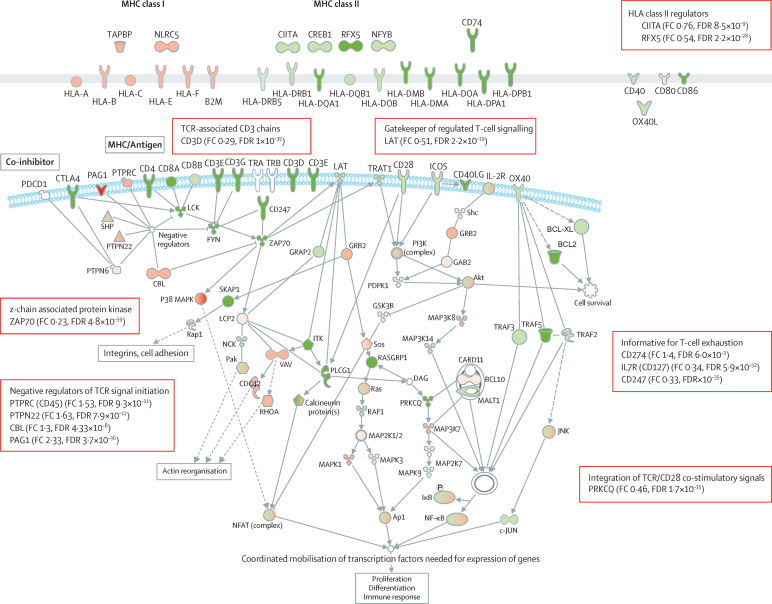
Overview of differentially expressed genes between SRS groups involving HLA and T-cell activationRed shading shows upregulation and green shading shows downregulation of genes (FC>1·5, FDR<0·05) for SRS1 versus SRS2. Solid lines show direct association, dashed lines show indirect association. SRS=sepsis response signature. FC=fold change. FDR=false discovery rate. MHC=major histocompatibility complex.